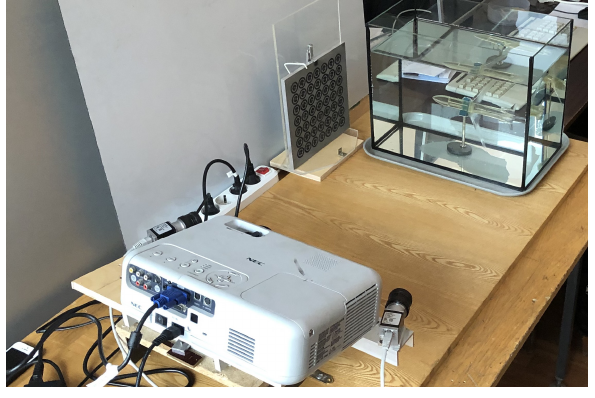
Figure 2. Motion capture system